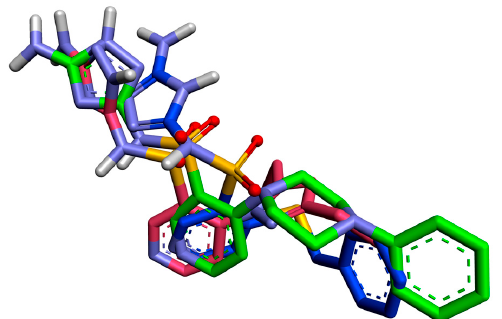
Figure 2. Superimposition of the computed binding geometry of compounds 26 (green), 34 (purple) and 35 (blue). Atoms other than carbon: sulfur — yellow, nitrogen — violet, oxygen — red, hydrogen — grey.